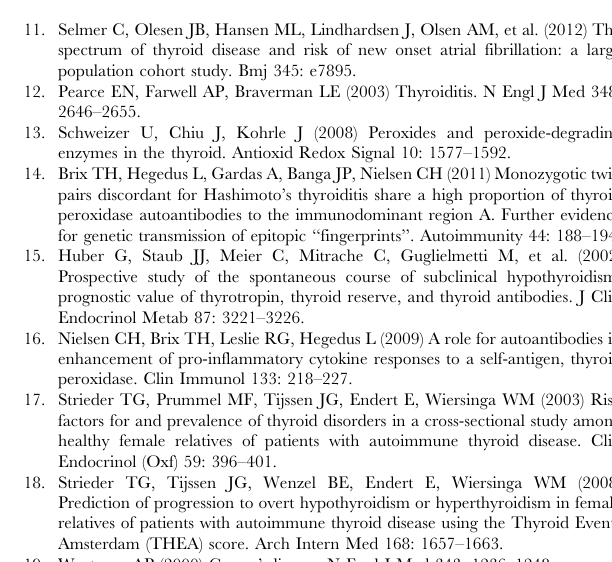
Table S7 Top IPA associated networks for the Stage 1 TPOAb- positivity and TPOAb level lead SNPs. Table S8 Top IPA associated canonical pathways for the Stage 1 TPOAb-positivity and TPOAb level lead